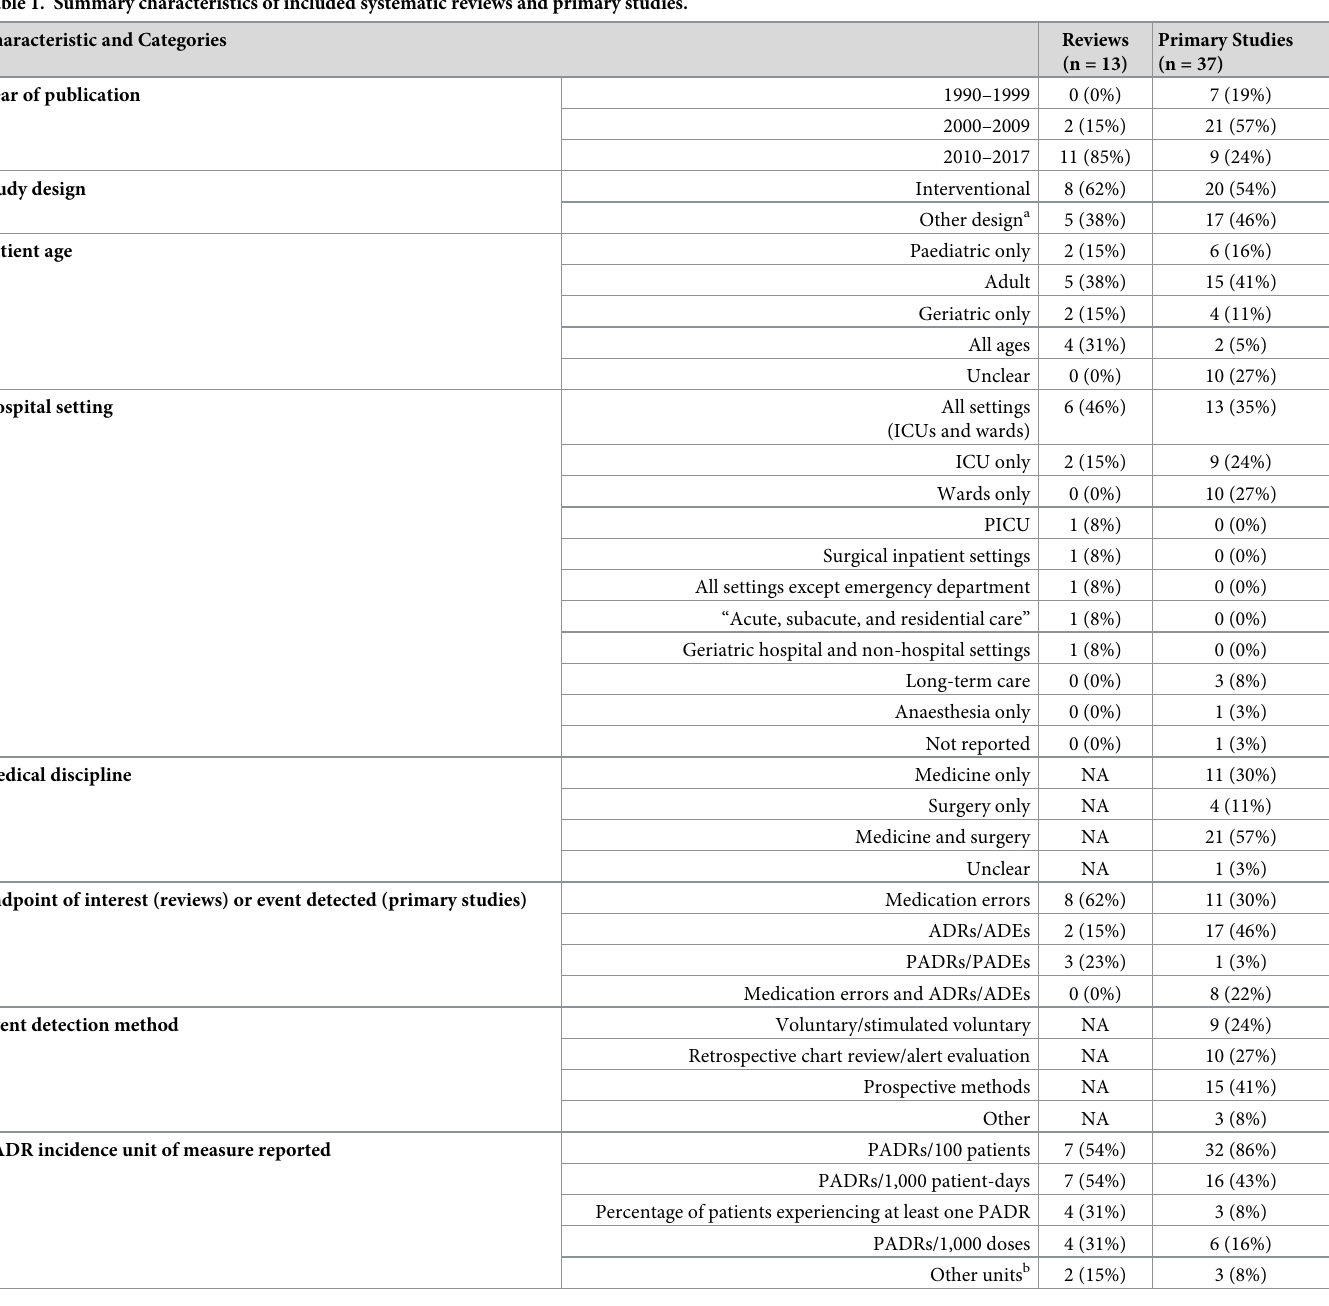
Table 1. Summary characteristics of included systematic reviews and primary